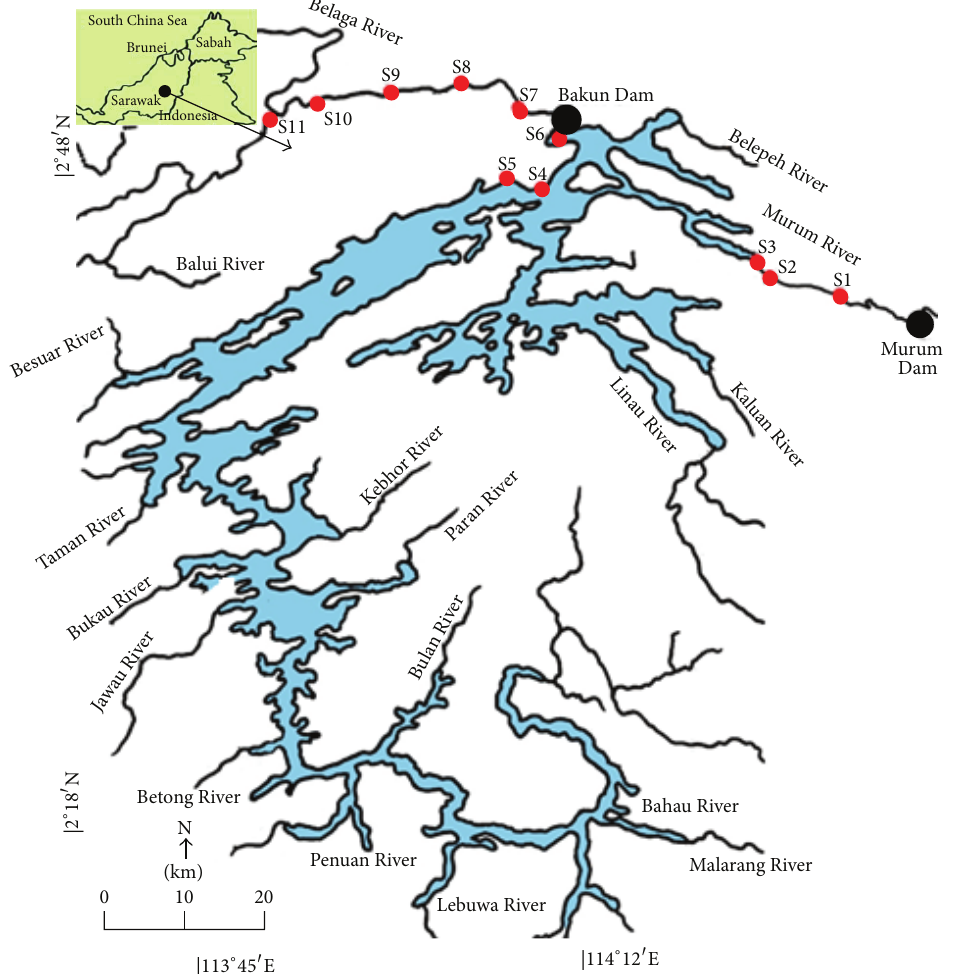
Figure 1: The locations of sampling